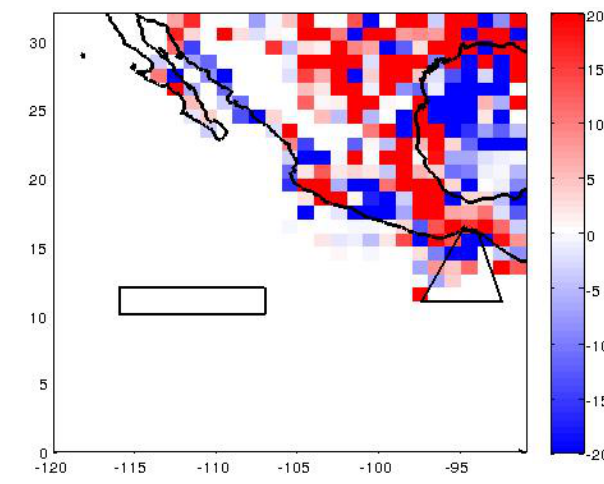
Fig. 13. Differences between average numbers of lightning flashes registered during days with moderate AOD (0.2–0.35) and low AOD (0.05–0.015).